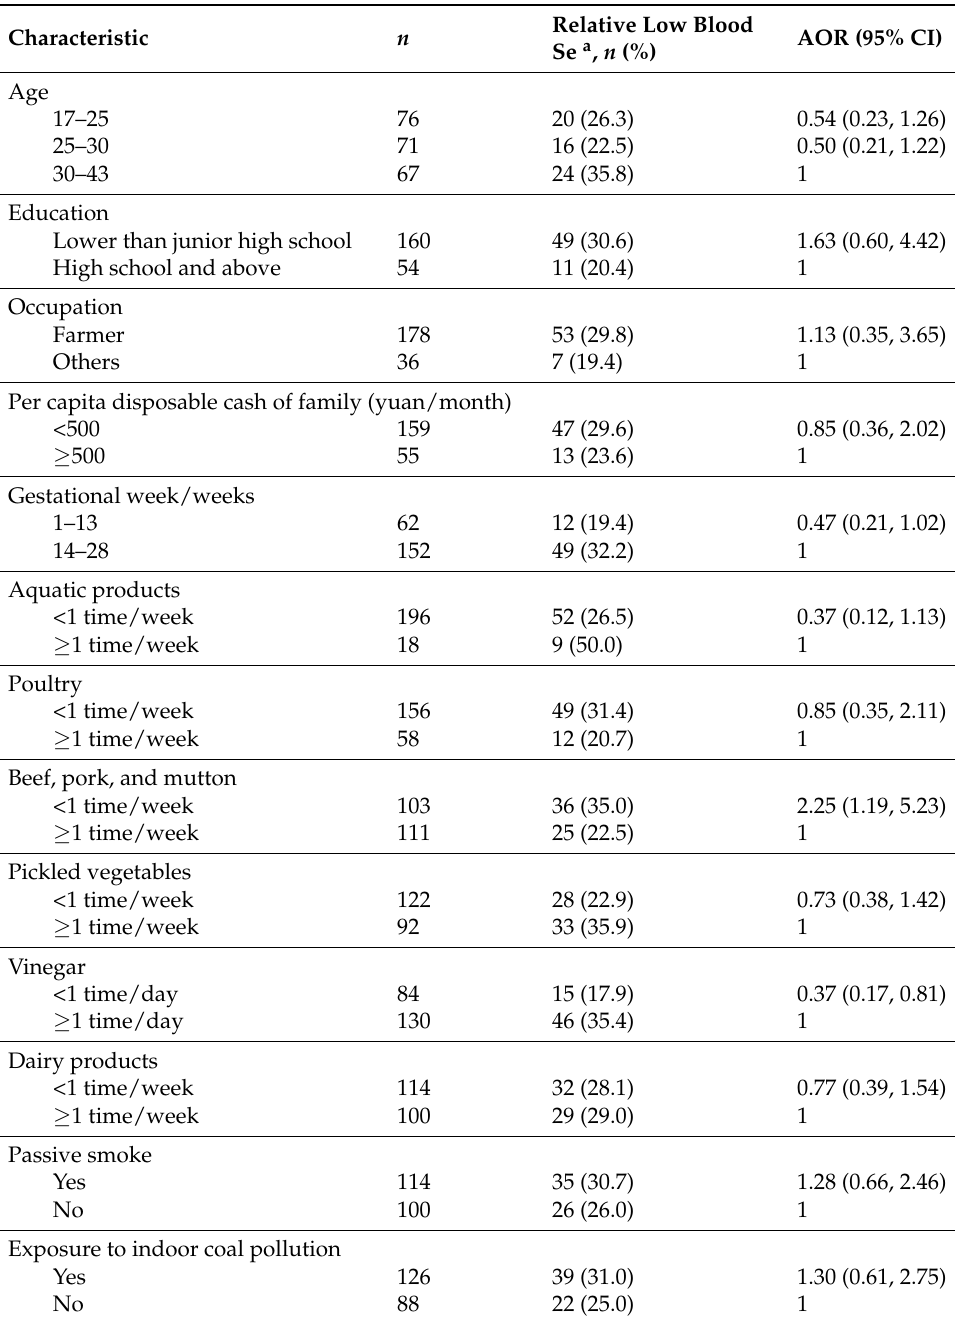
Table A1. Factors associated with low levels of Se in blood among pregnant women in a rural area of